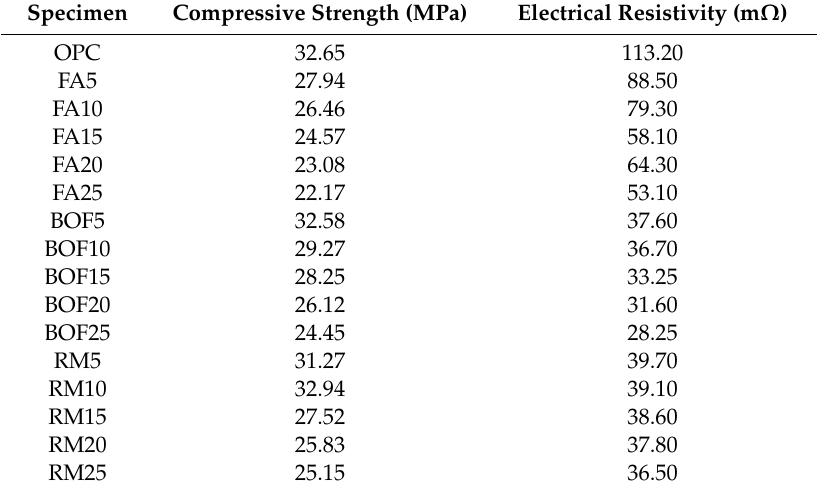
Table A3. Compressive strength and electrical resistance results for the environment-friendly, self-sensing concrete cured at the age of 28